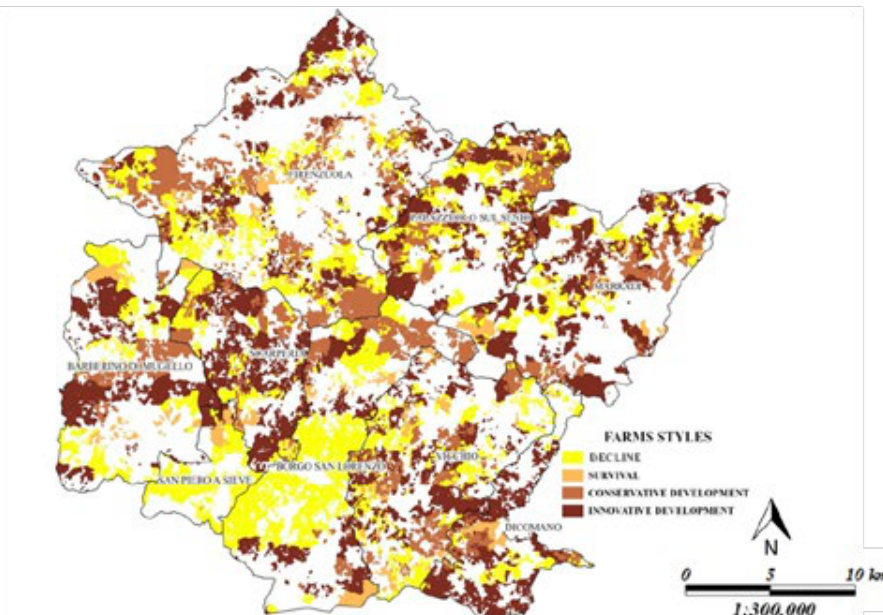
Figure 8 . The farming styles distribution in